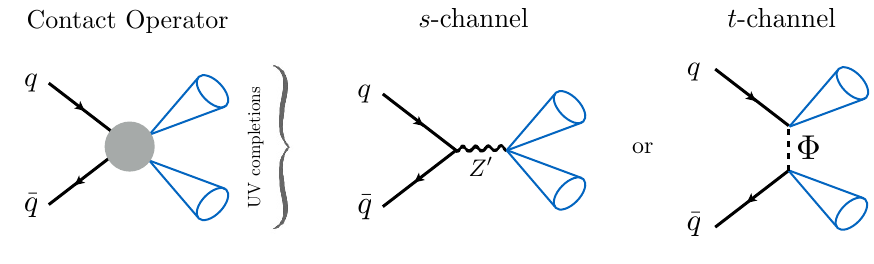
Figure 3 . The portals considered in this